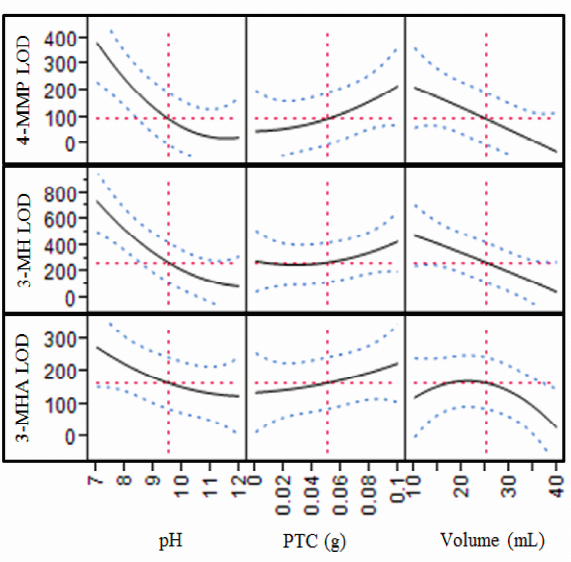
Figure 2. Effects of pH, PTC concentration, and sample volume on limits of detection for each thiol. The optimization was performed using a multifactorial CCF model. The red dotted lines show the mean values within a factor ( vertical lines ) or for a thiol detection limit ( horizontal lines ). The blue dotted lines represent the error